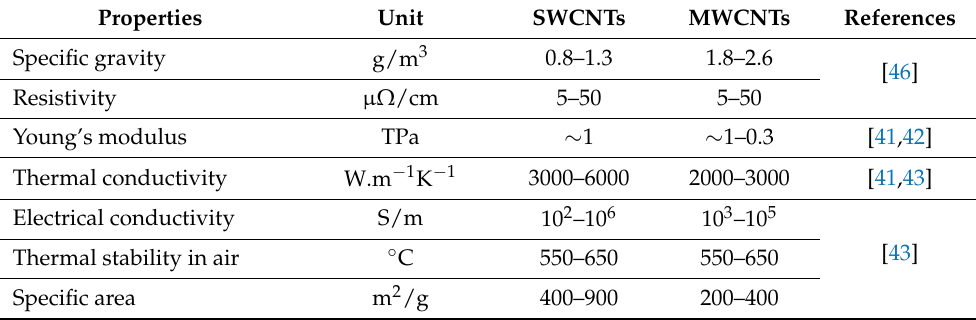
Table 2. Summary of the main properties of SWCNTs and